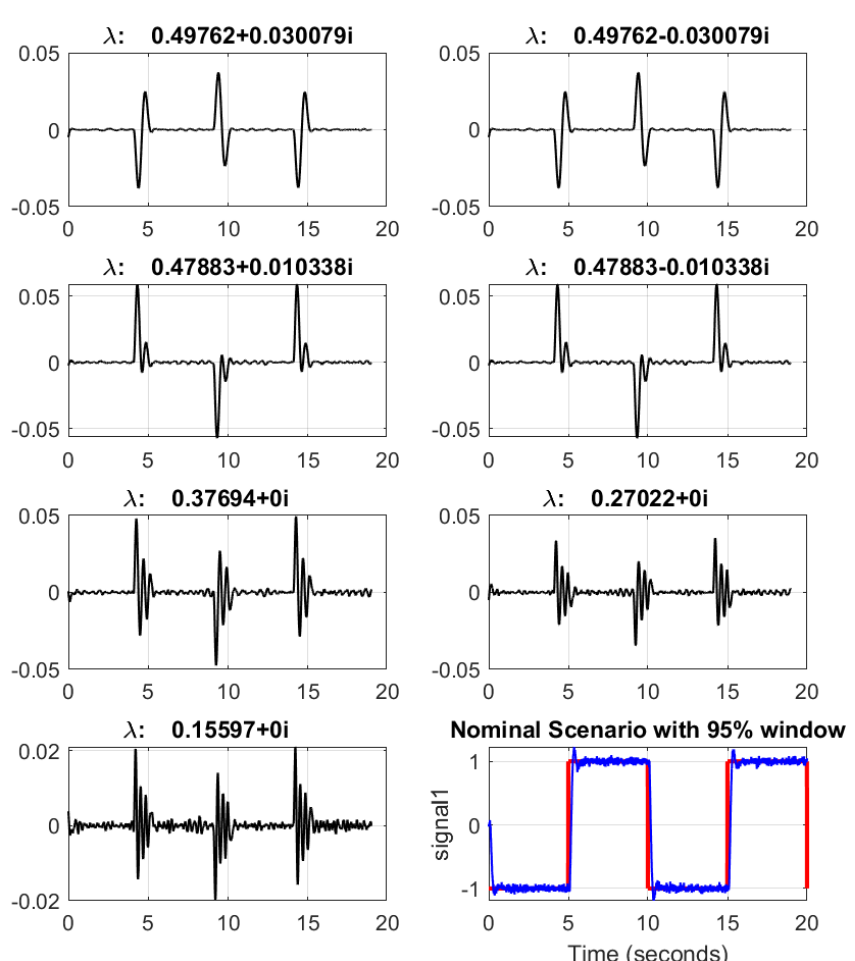
Figure 6. Data spatial temporal modes for nominal scenario in the reference case study using the first seven singular values.